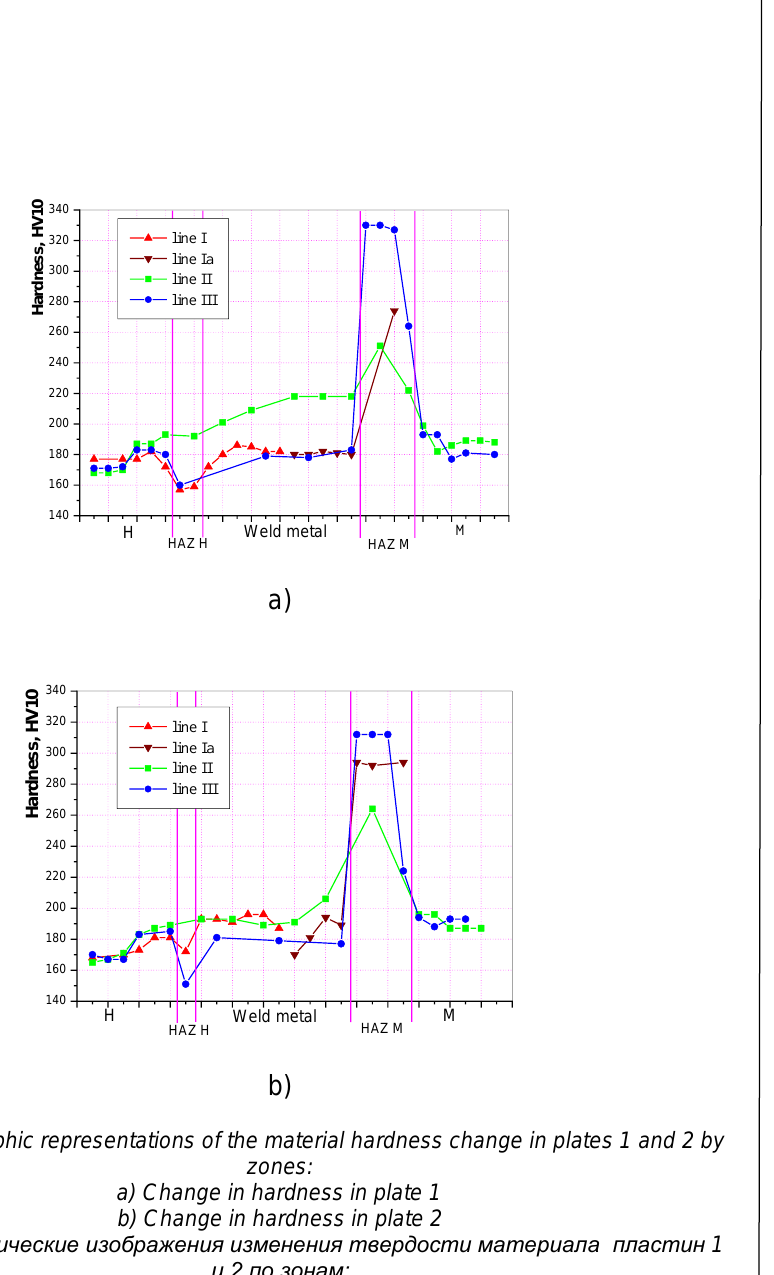
Figure 14 – Graphic representations of the material hardness change in plates 1 and 2 by zones: a) Change in hardness in plate 1 b) Change in hardness in plate